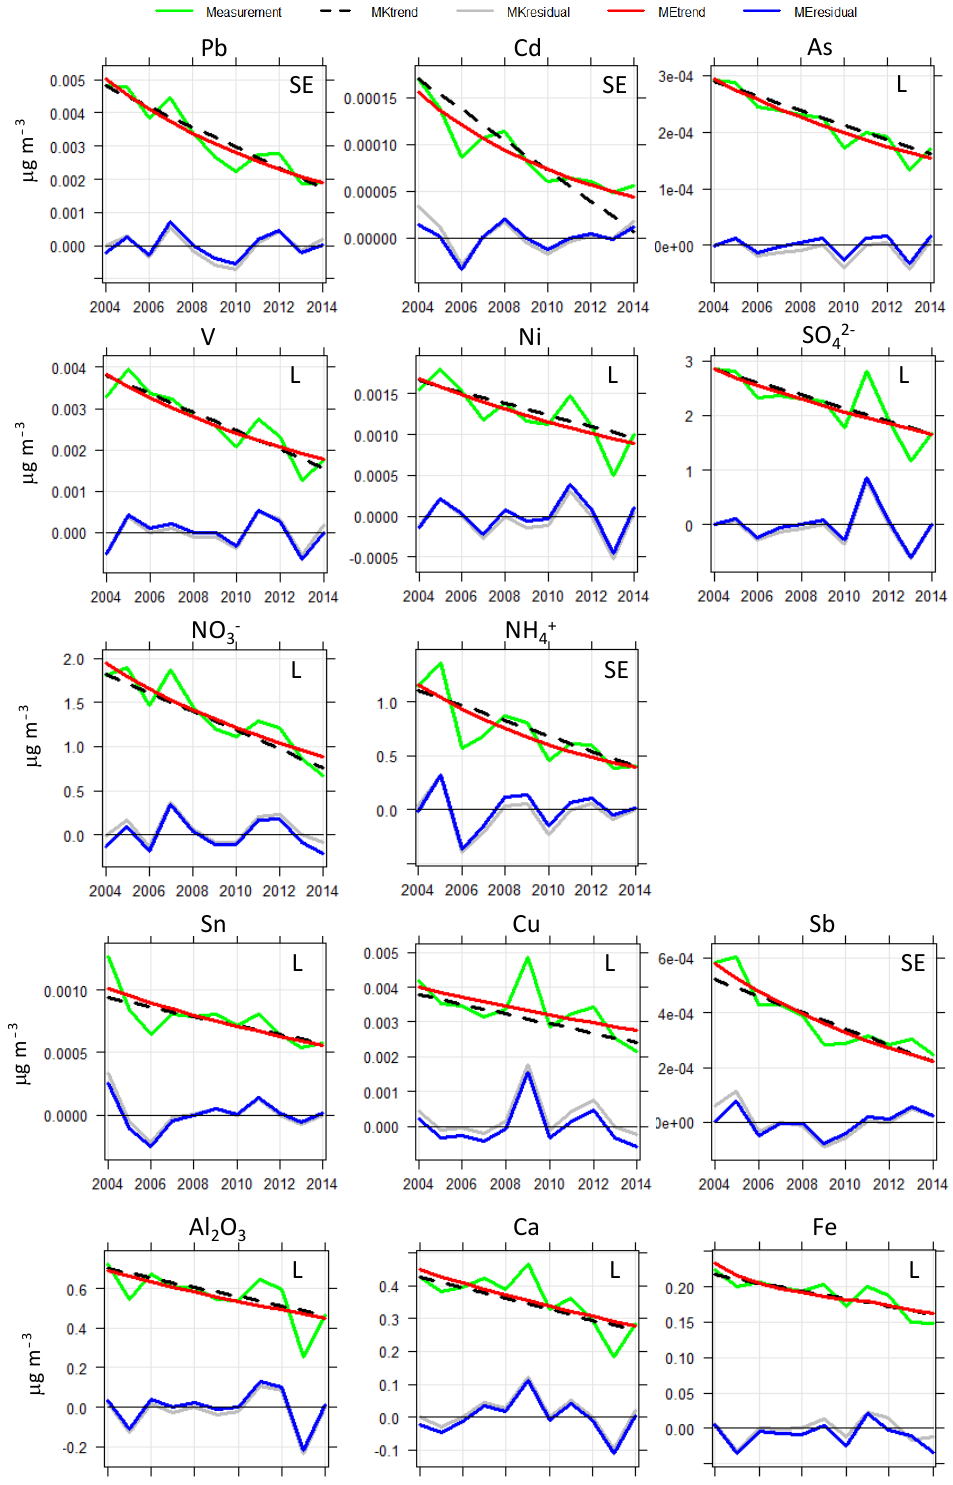
Figure 4. Mann–Kendall (MK) and multi-exponential (ME) trends for chemical species at MSY in PM 10 . Measured concentration (green line); multi-exponential trend (red line); multi-exponential residuals (blue line); Mann–Kendall trend (black line); Mann–Kendall residuals (gray line). Trend type: linear (L), single exponential (SE), double exponential